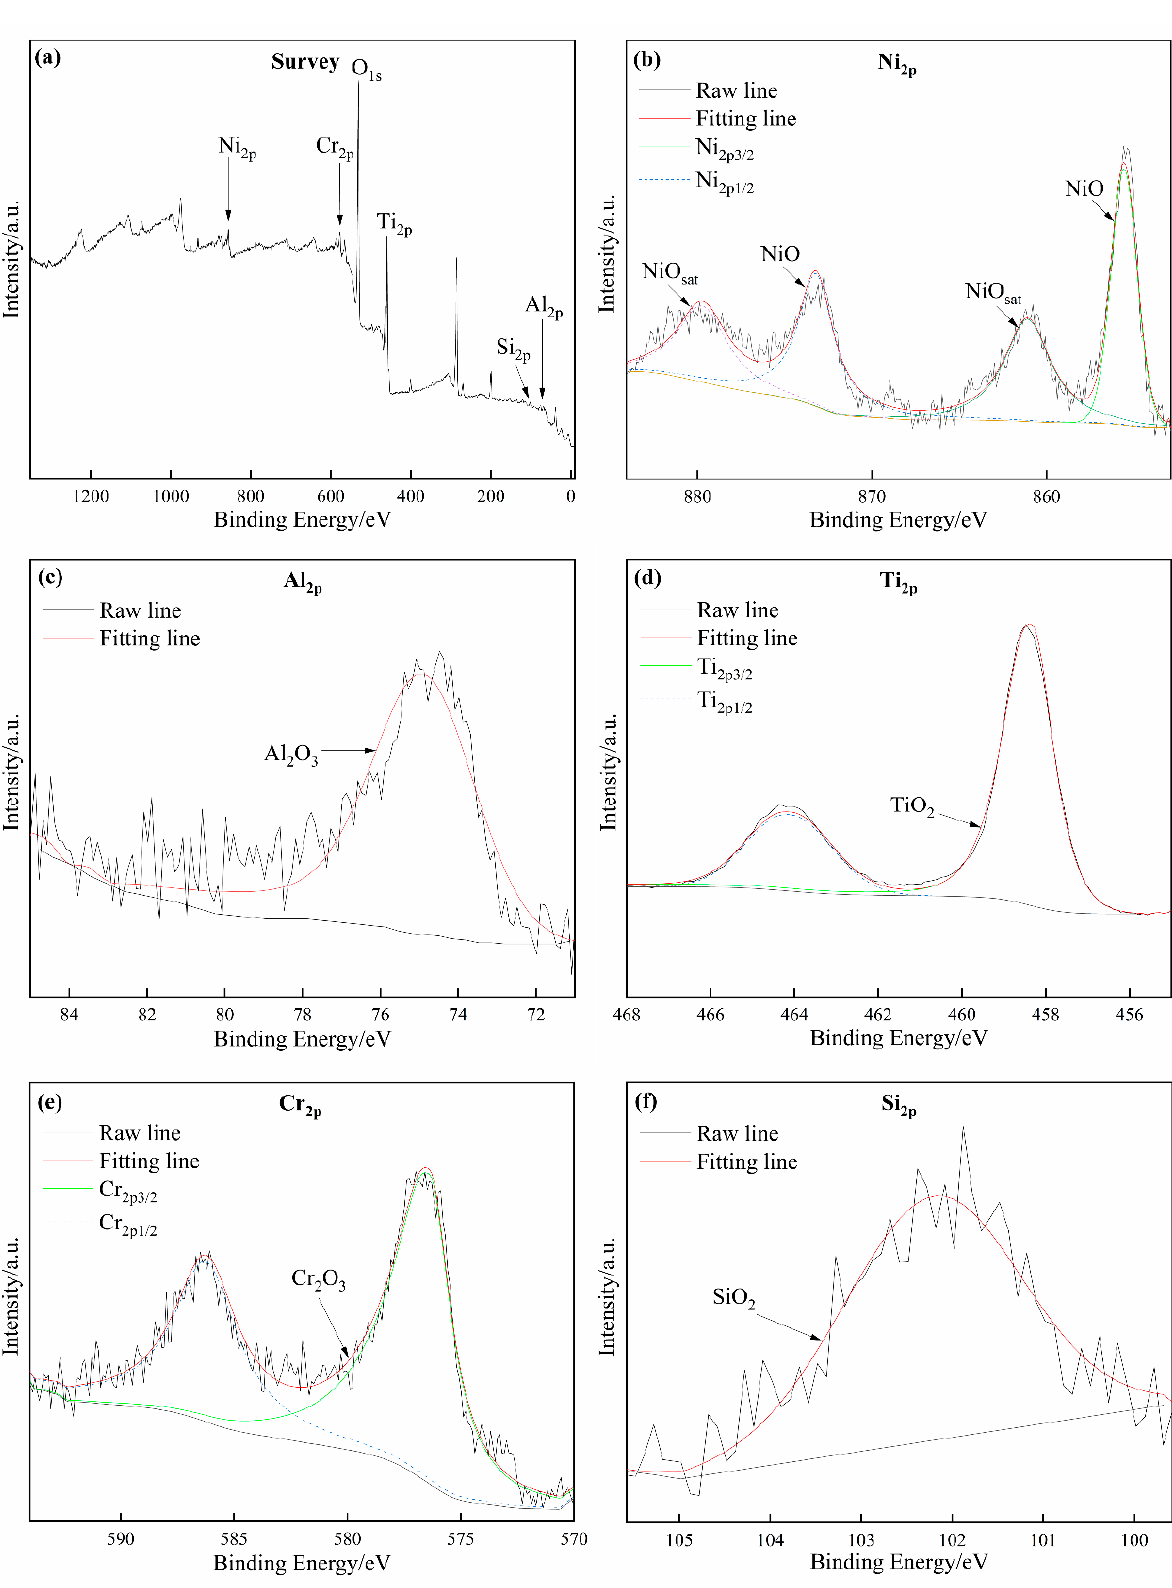
Figure 12. XPS spectra of the oxide film formed on the surface of Coating 2 for 11 mm ∙ s − 1 : ( a ) Survey; ( b ) Ni 2p ; ( c ) Al 2p ; ( d ) Ti 2p ; ( e ) Cr 2p ; ( f ) Si 2p .